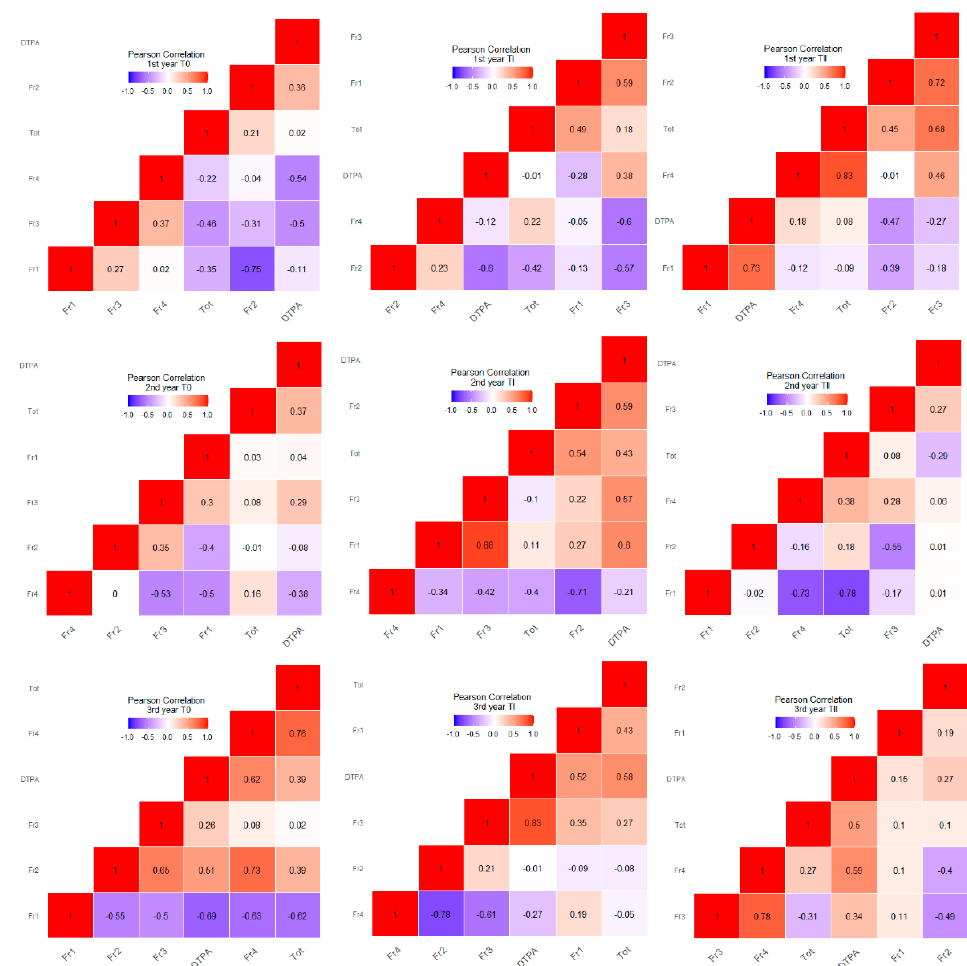
Figure 3. Heat maps presenting Pearson’s correlation coefficient between Pb in Fr. 1–Fr. 4, Pb Tot and